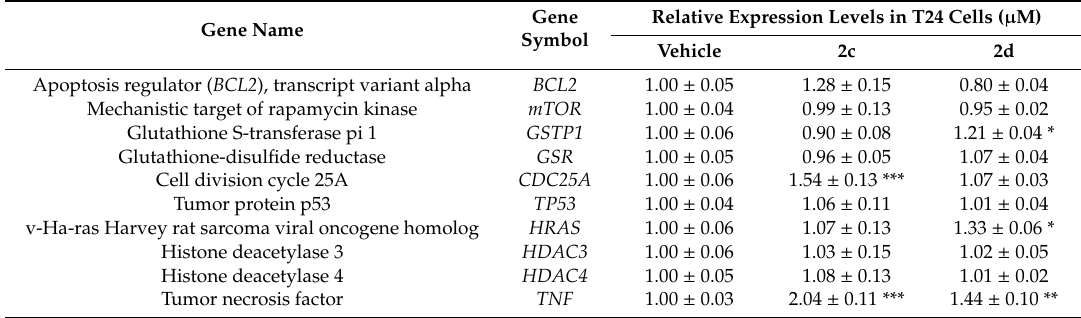
Table 3. Relative expression levels of genes implicated in anti-cancer e ff ects in T24 cells after treatment with compounds 2c and 2d